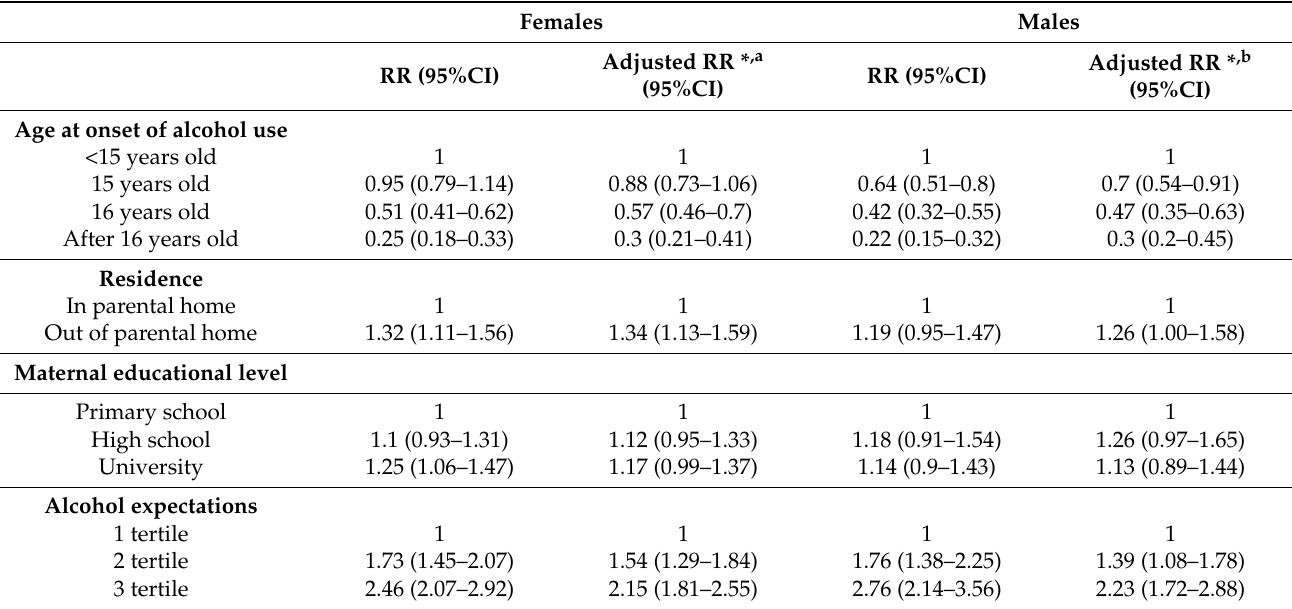
Table 4. Influence of explanatory factors in second domain (alcohol dependence) of AUDIT test score by gender. Negative binomial regression.